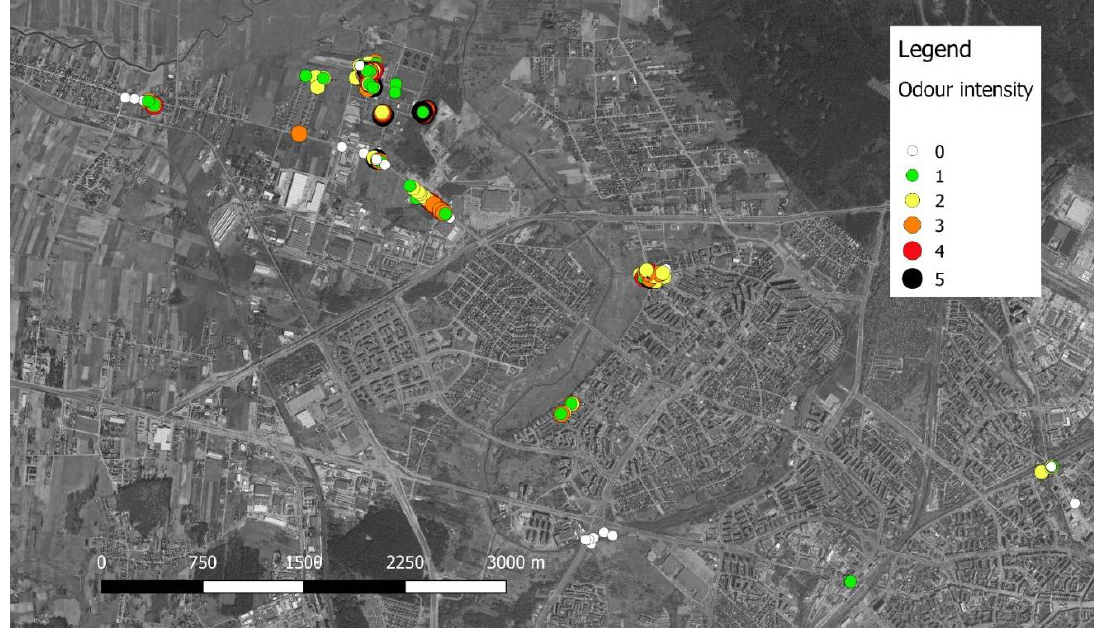
Figure 4. i od in the atmosphere of the north-western part of Białystok (at a height of 1.8 m).